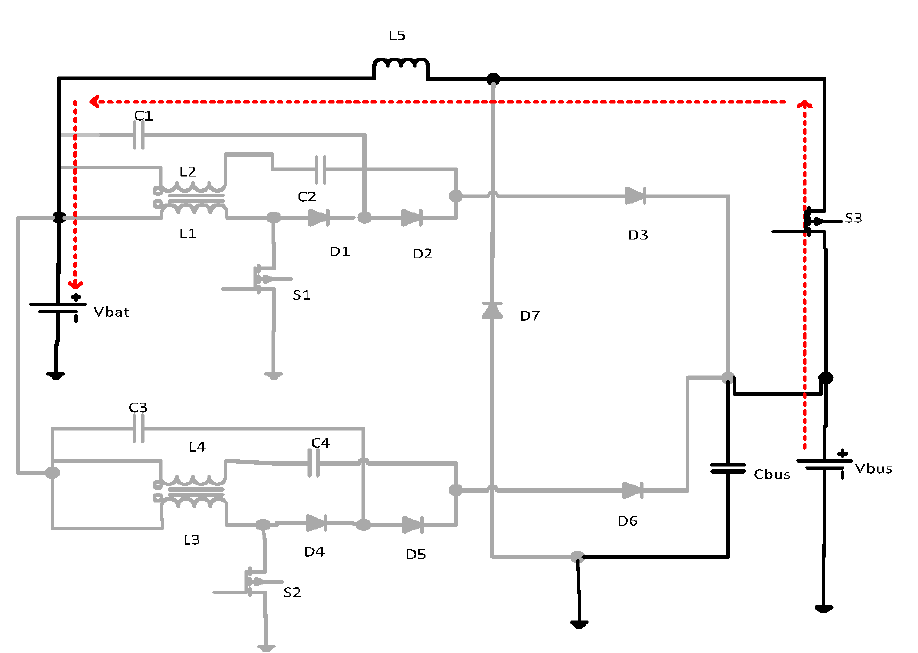
Figure 4. Mode 1 (switch closed).